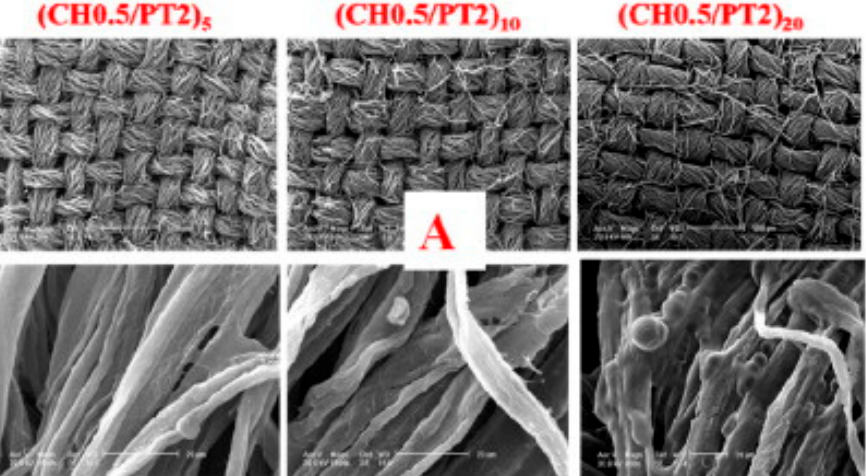
Figure 8. Scheme of the Layer-by-Layer process. PT = phosphorylated chitin. Reprinted with permission from [39]. Copyright 2015, Elsevier.